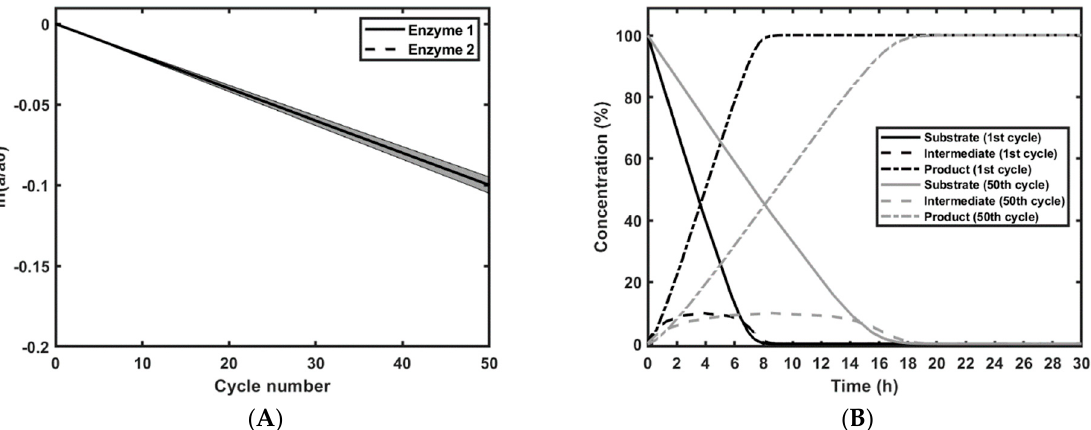
Figure 3. Effect on reaction course when both enzymes deactivate at a similar rate. ( A ) Deactivation course of enzyme 1 and enzyme 2. The deactivation is assumed to be first-order, with a deactivation constant of 0.002 h − 1 for both enzymes. The shaded area indicates an error of ±5%. ( B ) Simulated time course of the concentration profile. The black line shows the initial reaction cycles, and the grey lines illustrate the time course of the 50th reaction cycle in the presence of deactivation, with a deactivation constant at 0.002 h − 1 . Kinetic parameters and initial enzyme concentrations are listed in Table 1.